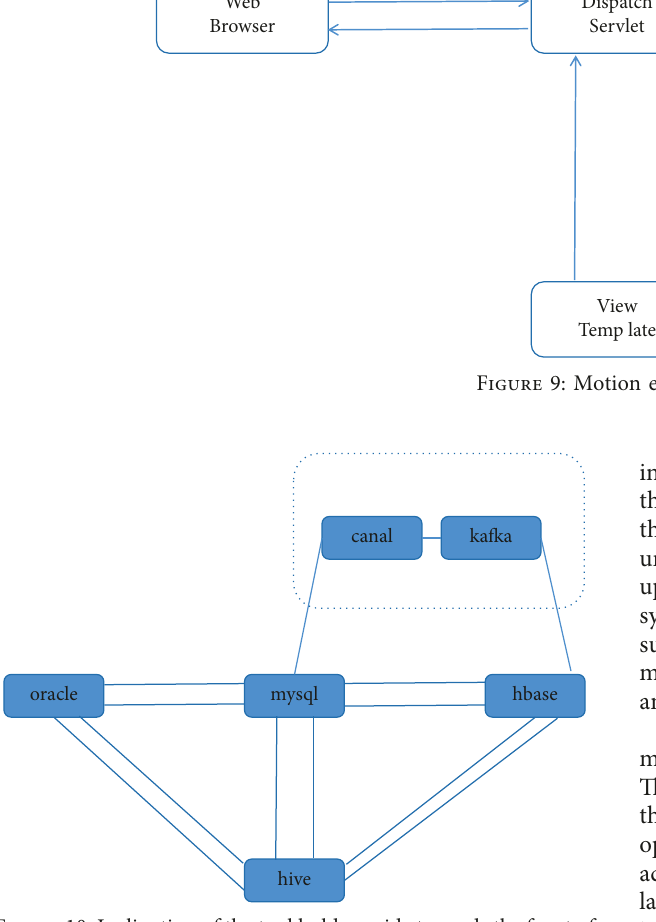
Figure 10: Inclination of the tool holder guide towards the front of the